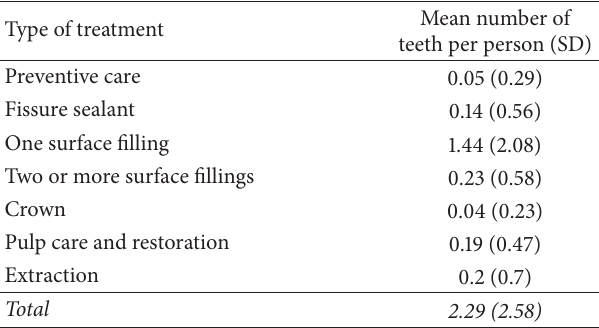
Table 4: Mean number of teeth per person according to treatment